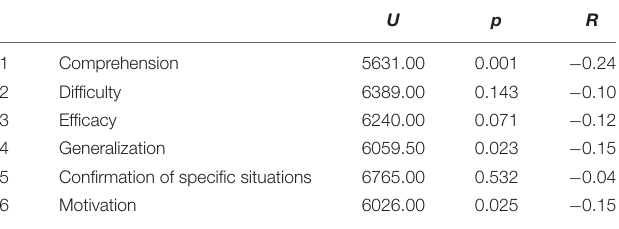
TABLE 3 | Result of Mann-Whitney U -test on impression